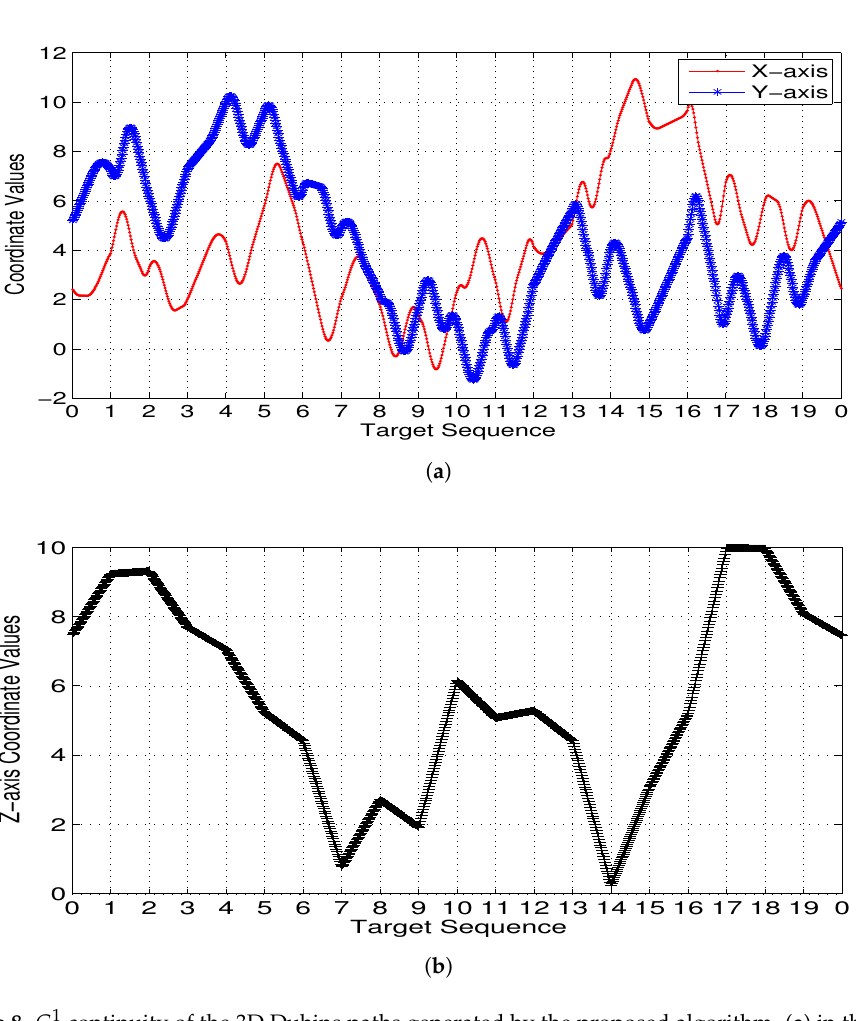
Figure 8. G 1 continuity of the 3D Dubins paths generated by the proposed algorithm. ( a ) in the X − Y plane; ( b ) in the Z axis.